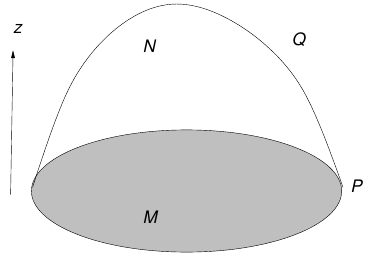
Figure 1 . BCFT on M and its dual N